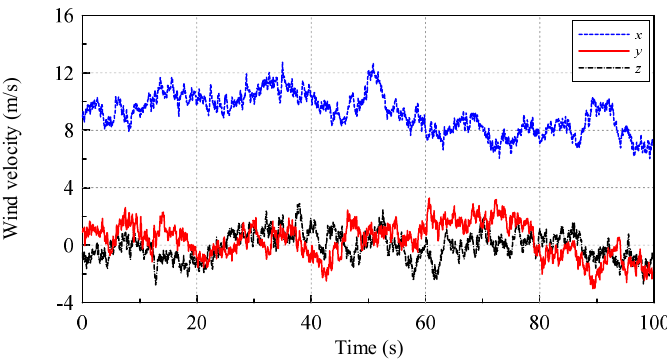
Figure 13. Annual wind speed V ave = 9.2 m/s at 90 m elevation.